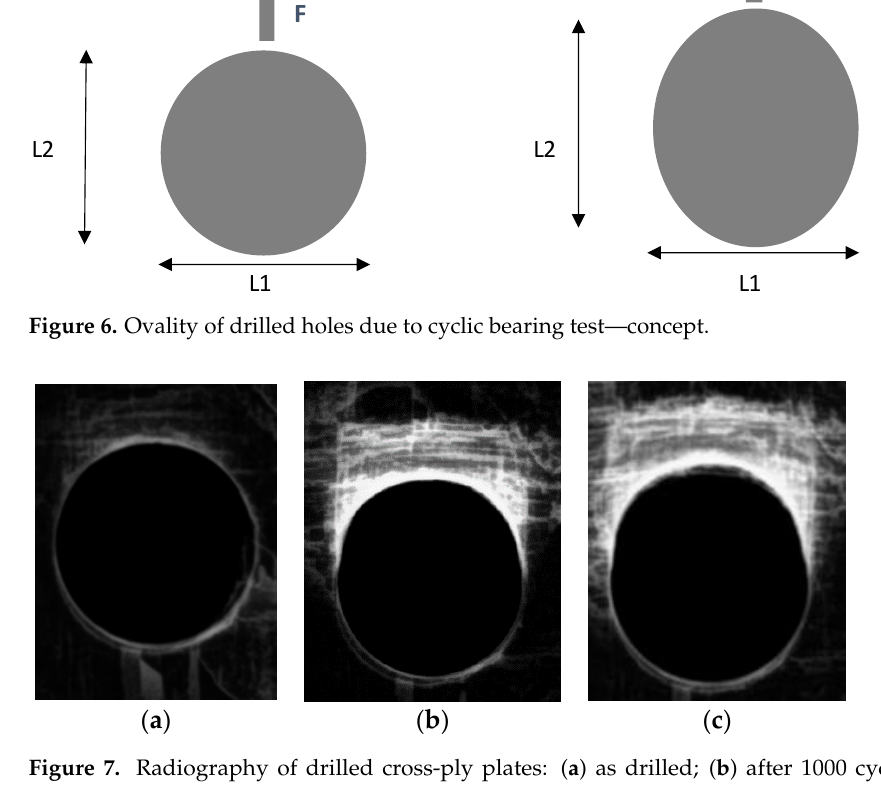
Figure 7. Radiography of drilled cross-ply plates: ( a ) as drilled; ( b ) after 1000 cycles; ( c ) after 2000 cycles — ovality in the load direction (top) is evident.